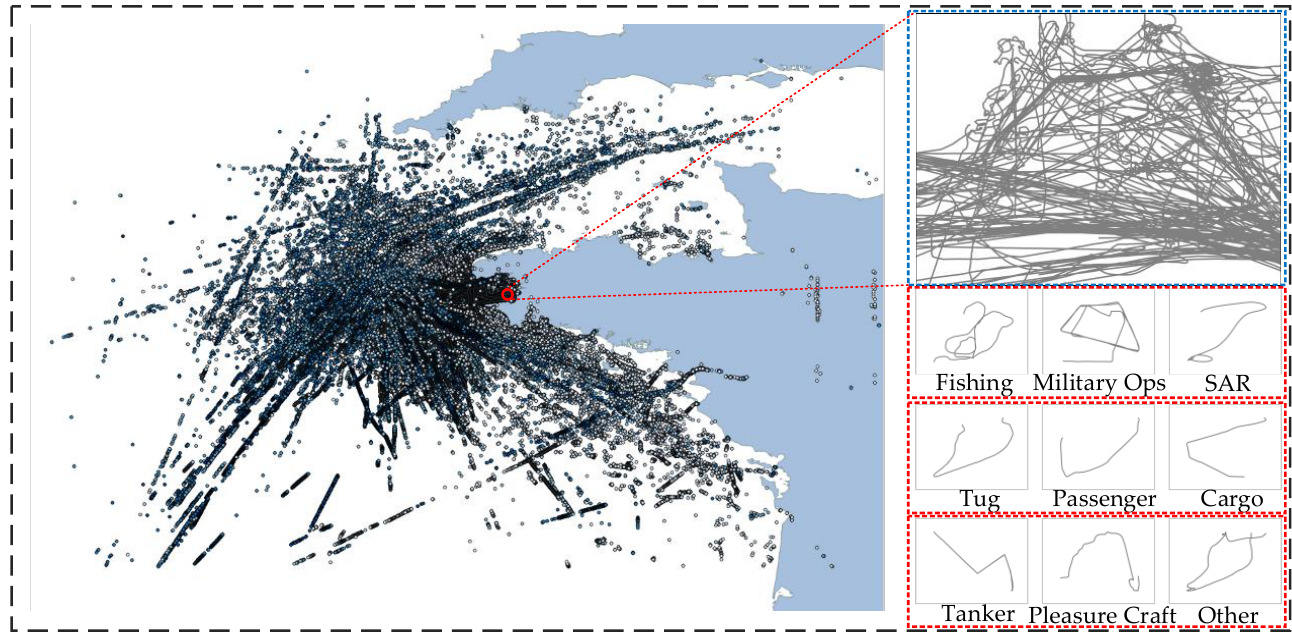
Figure 4. AIS data plot.